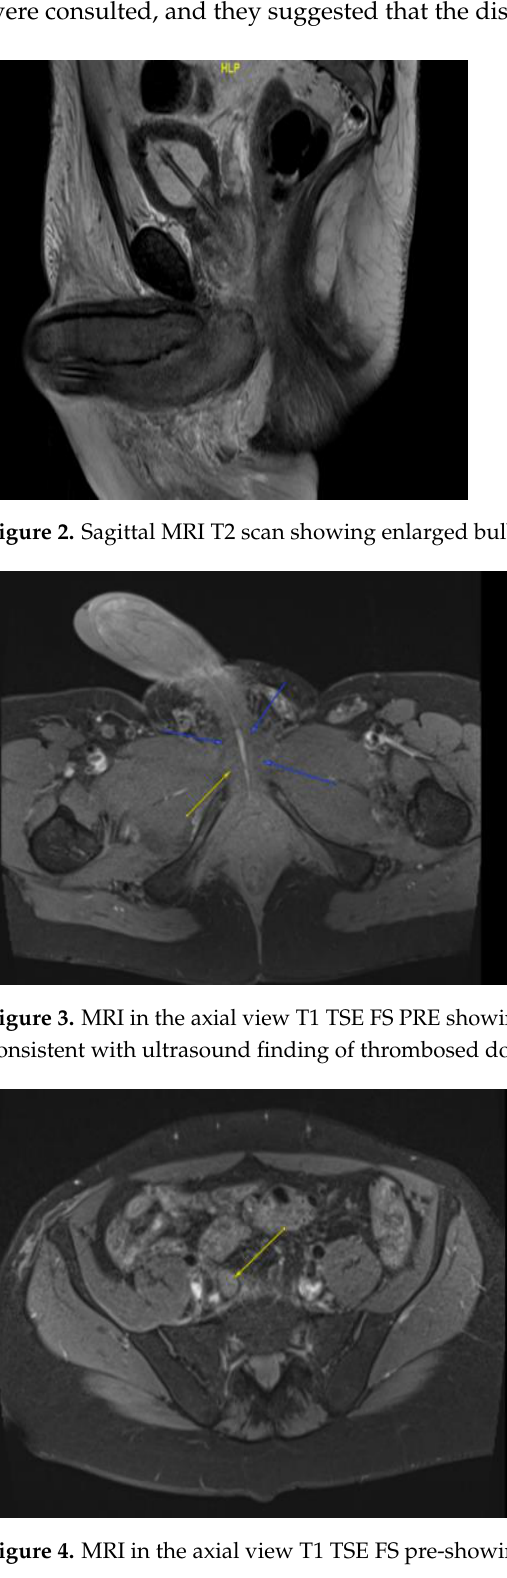
Figure 2. Sagittal MRI T2 scan showing enlarged bulbospongiosus.